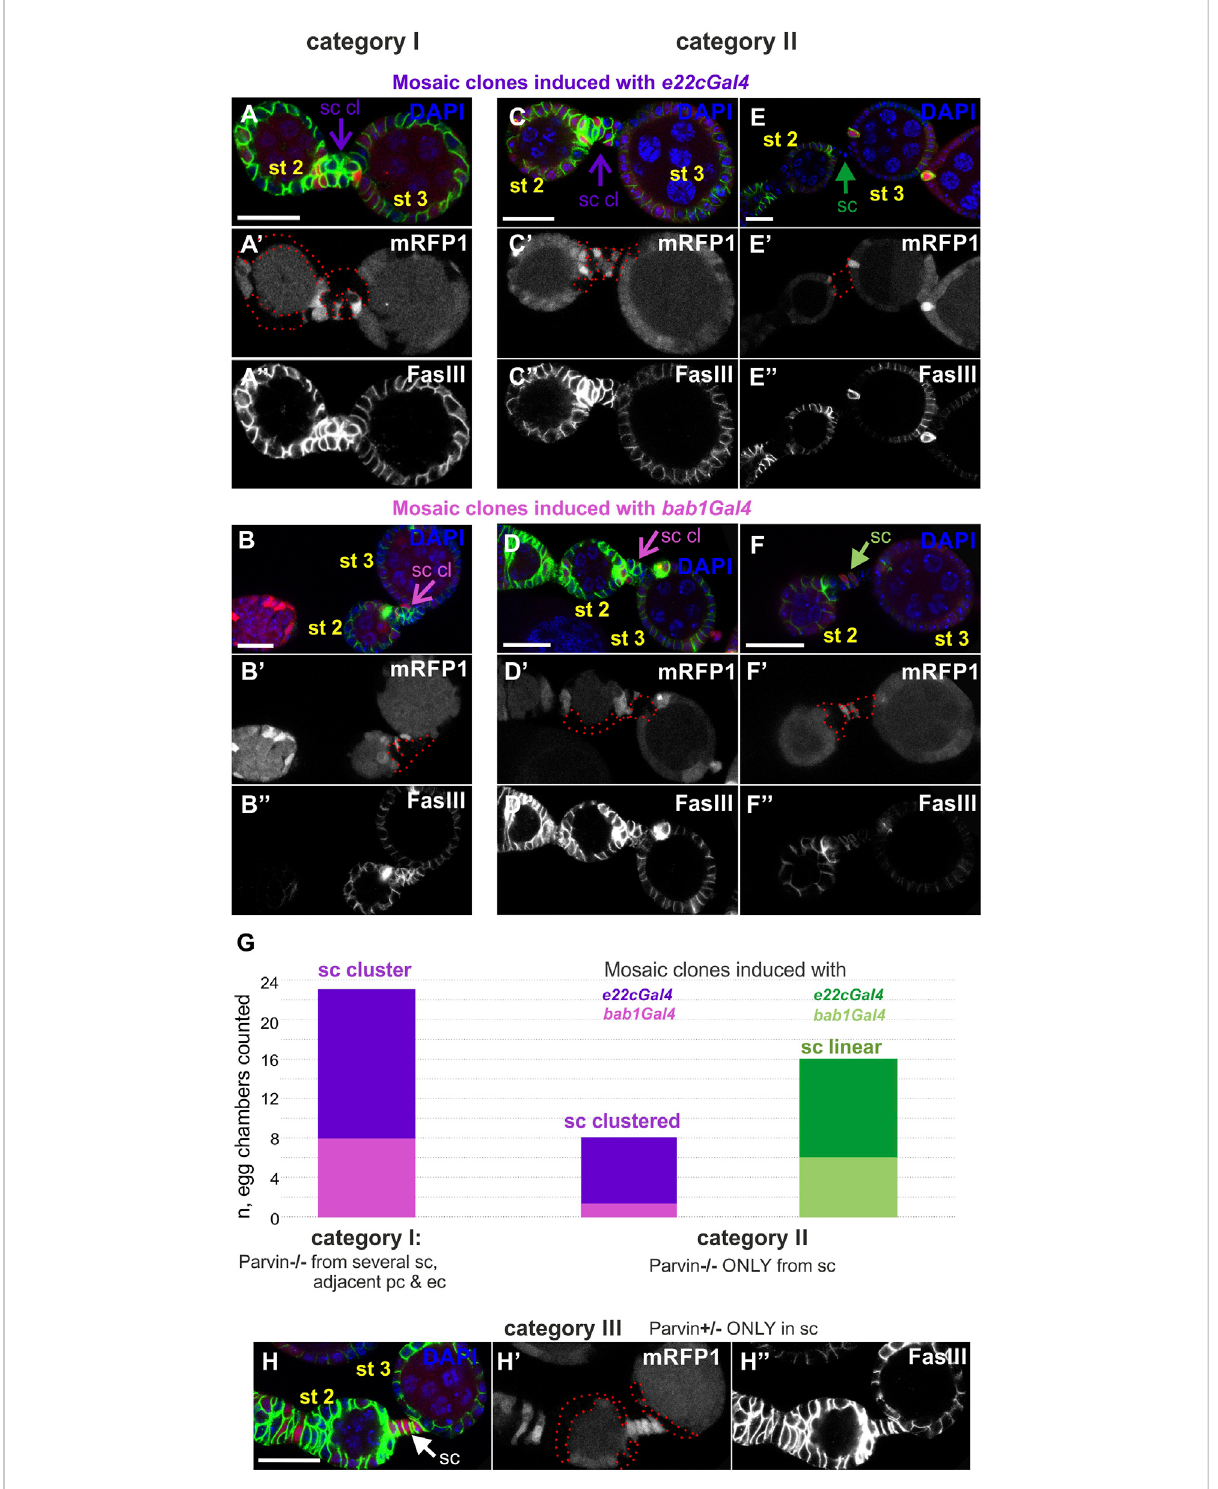
FIGURE 12 Cell-autonomous and non-cell-autonomous effect of Parvin genetic mosaics in the interfollicular stalk formation. Confocal micrographs of early stage (st2 to st3) egg chambers derived from (A,E") Parvin A adult mosaic fl ies generated by e22cGal4 (B,F") Parvin A adult mosaic fl ies generated by bab1Gal4 . (A 9 – F 9 ) Parvin A mutant cells were marked by the absence of the mRFP1 and are highlighted with a red dashed line. Co-staining with FasIII labels follicle epithelial cells. (A,B") Parvin mutant clones generated with (A-A") e22cGal4 or (B,B") bab1Gal4 in stalk cells and in